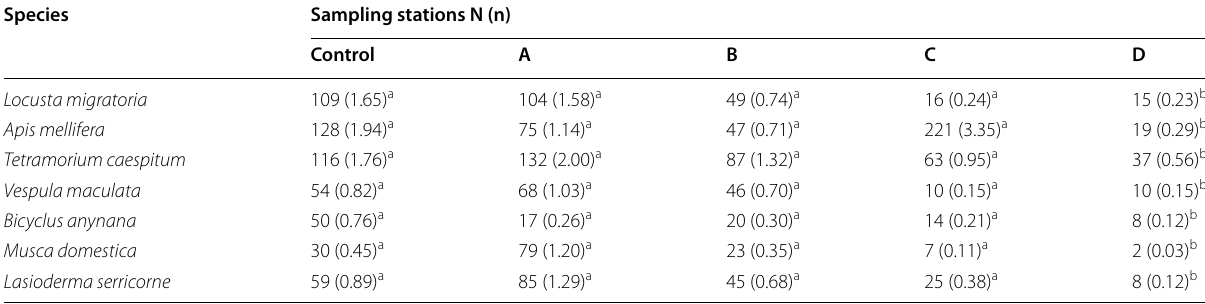
N Number of individuals, n number of individuals per station per week, values along row with different superscripts are significantly different ( P > 0.05) = =